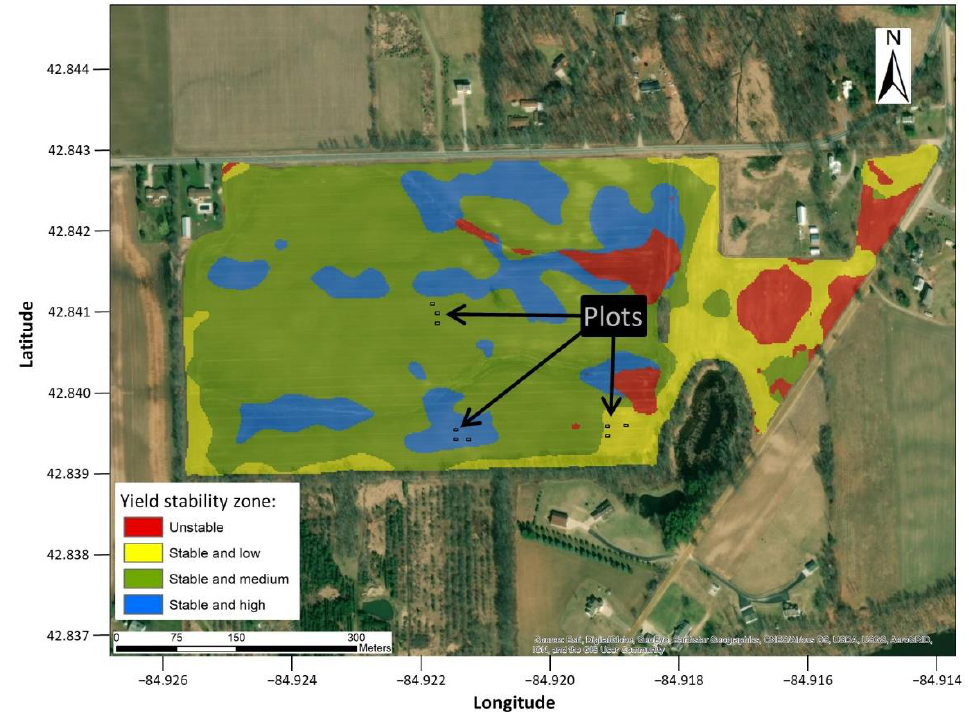
Figure 1. Geographical location of the commercial crop field and the plots established within three yield stability